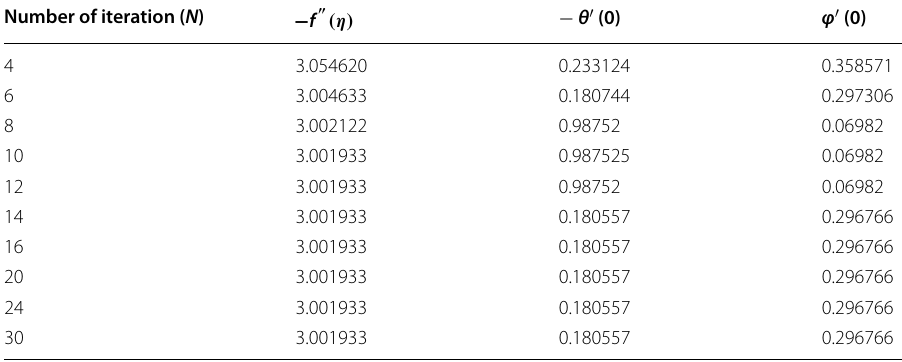
Table 1 SCM solutions in various approximation orders of convergence when